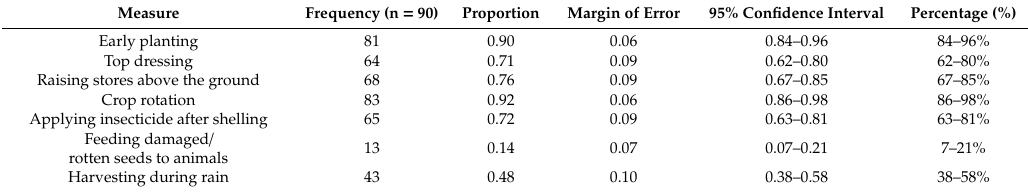
Table 2. Agricultural measures adopted by farmers in Nandi County and their confidence intervals.